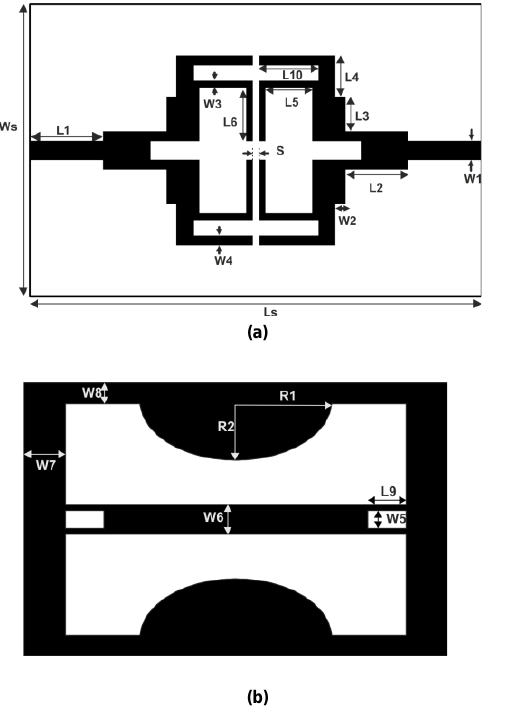
FIGURE 1. Geometry of the proposed UWB BPF: (a) top view, (b) bottom